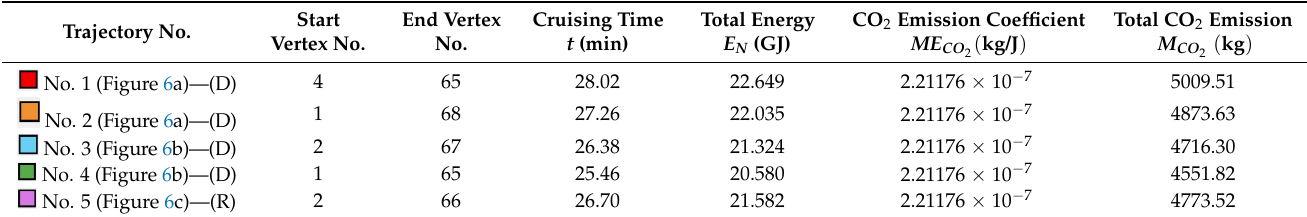
Table 6. Cruising time, and corresponding energy consumption and CO 2 emission during the flight along four determined trajectories (D) and a reference trajectory (R) on the Copenhagen–Gdansk route. Trajectory